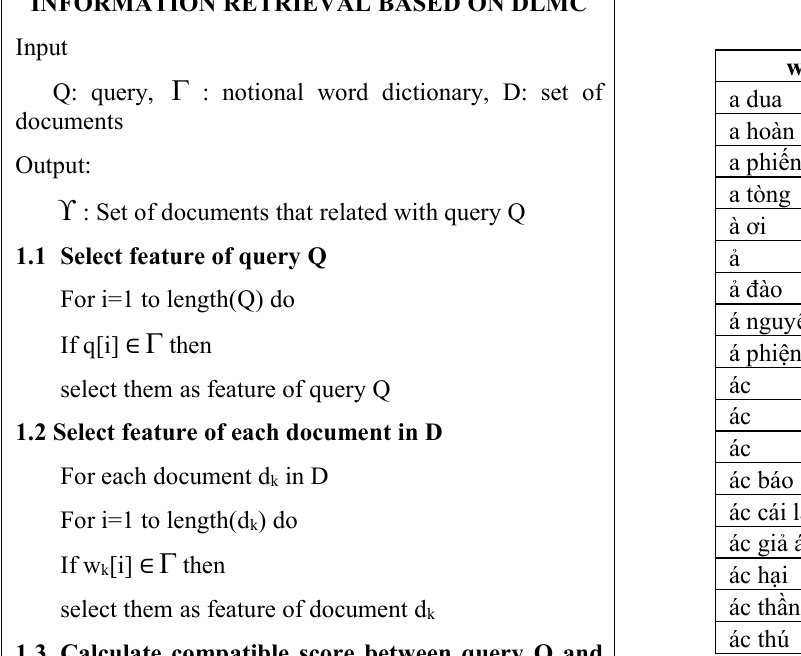
Figure 2. DLMC Model for Information retrieval Figure 2 describes the DLMC model. Given the query Q is separated into 03 notional words q 1 , q 2 and q 3 . These notional words are interconnected with each other by weighted arcs. Each notional word q j in query Q is matched with document d i in document set D for finding the relation between notional word qj and document d i . is calculated by the topic related score by formula (3). The relation of query Q and document d i is calculated by formula (4). Table1. Some notional words extracted from